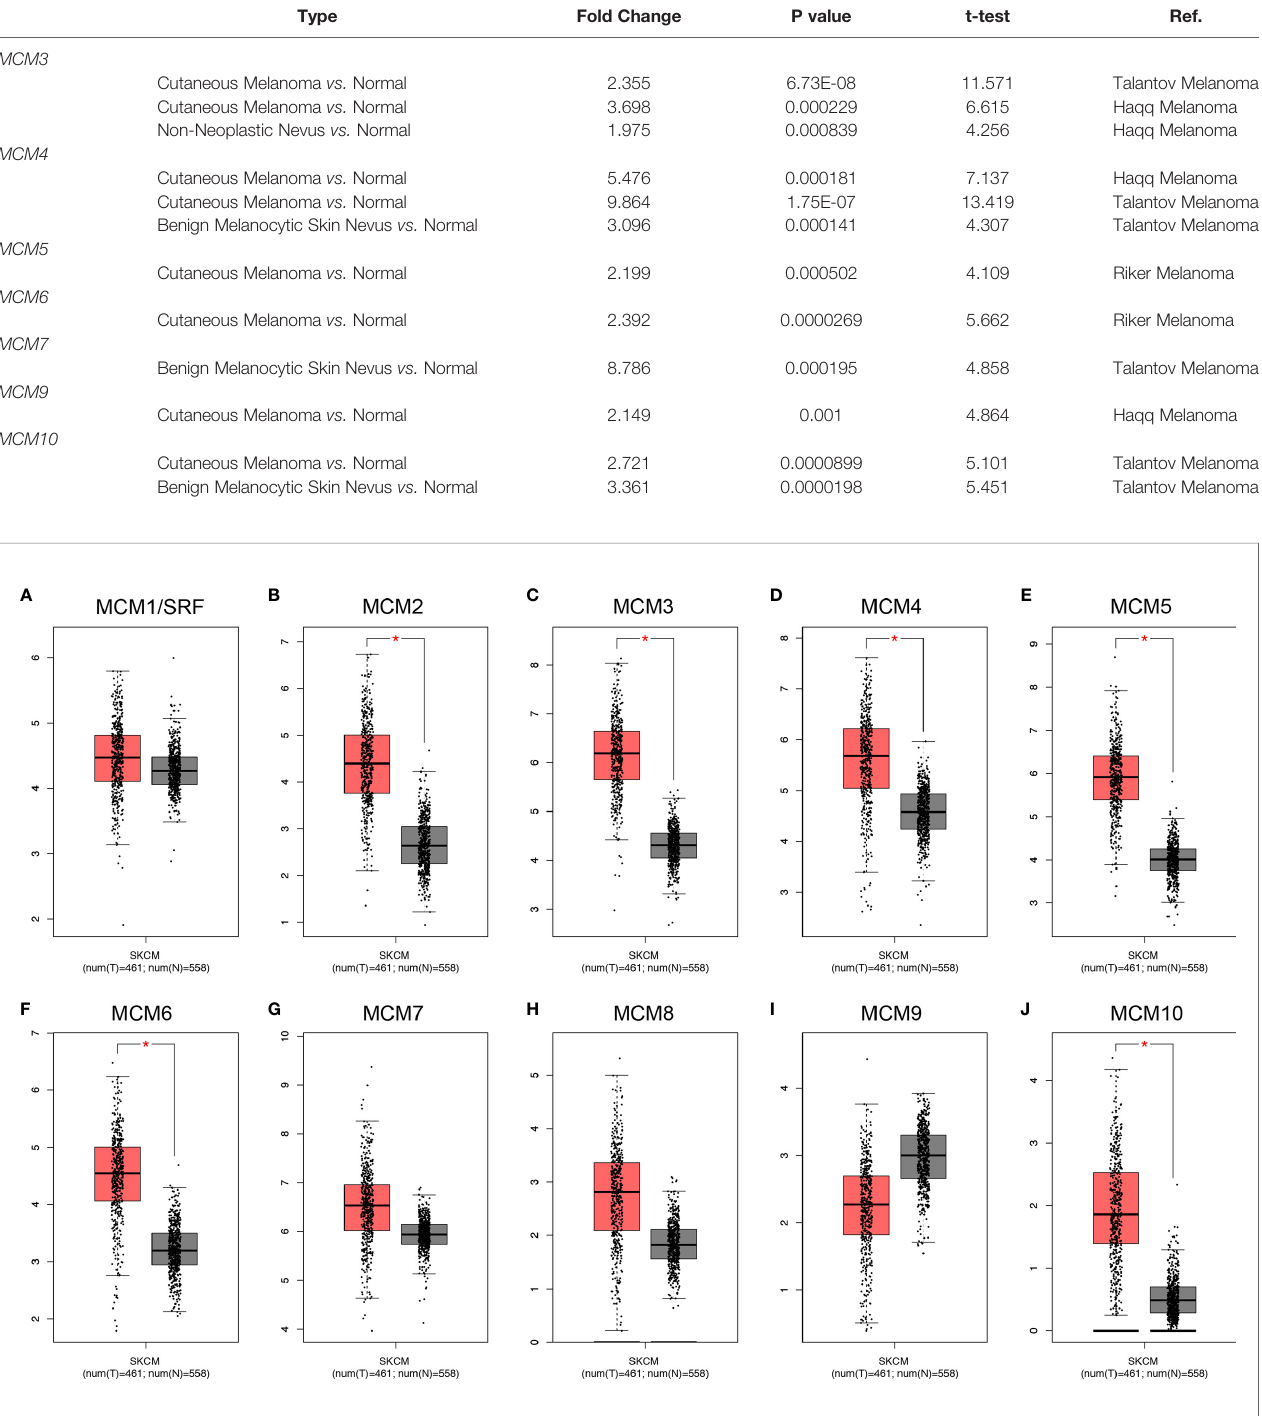
FIGURE 2 | Transcriptional expression of distinct MCM family members in TCGA cohort. (A – J) Except for MCM9 , GEPIA analyses showed that MCM1 – 8 and MCM10 were overexpressed in SKCM than in normal skin, although statistically signi fi cant differences were observed for MCM2 – 6 and MCM10 only (* p < 0.05).